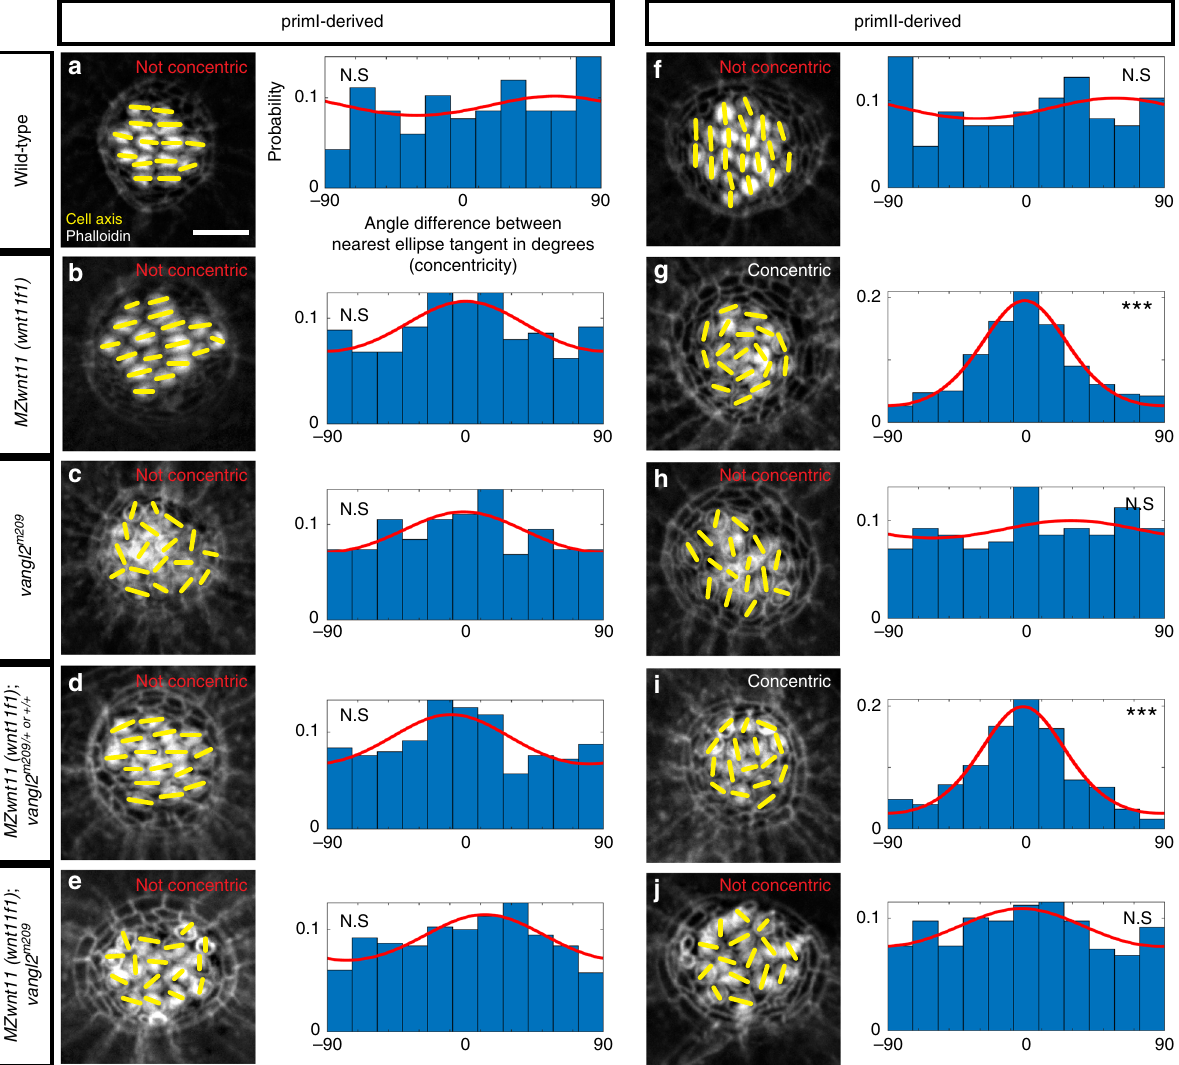
Fig. 2 PCP and Wnt pathway mutants possess different hair cell phenotypes. In PCP mutants hair cells are randomly oriented, whereas hair cells in primII